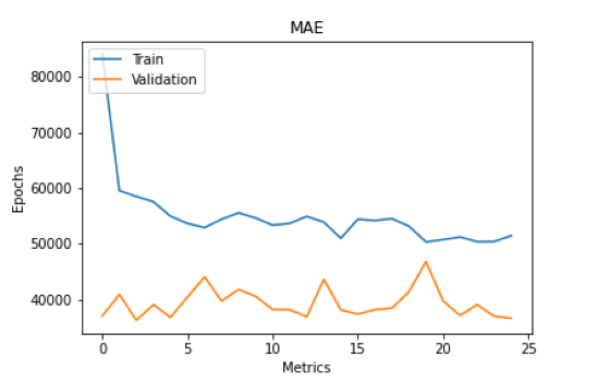
Figure 7. LSTM MAE